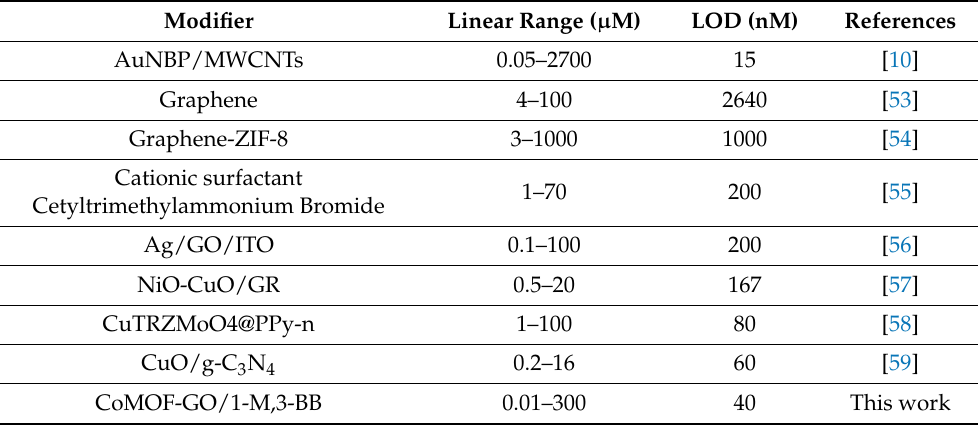
Table 2. A comparison between the analytical performances of the proposed electrode with other DA sensors.